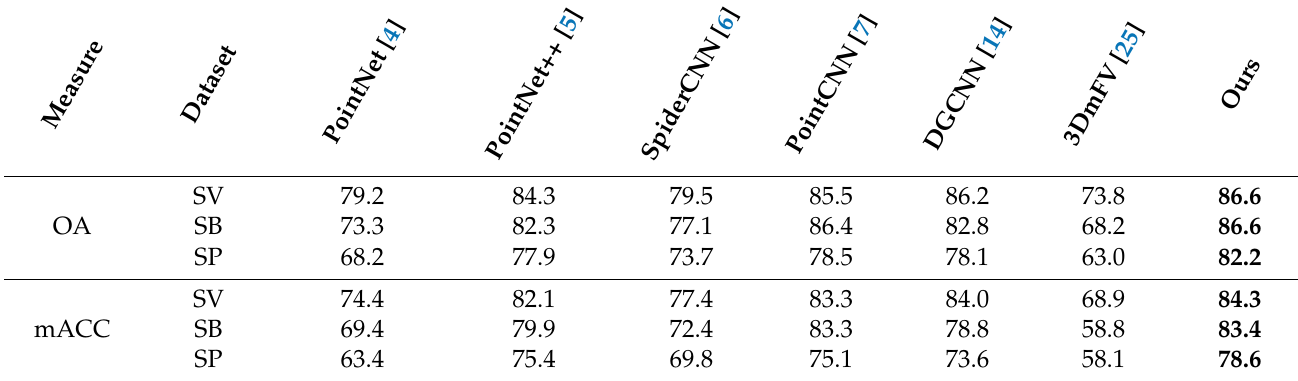
Table 2. Shape classification accuracy (OA and mACC in %) on ScanobjectNN-Vanilla (SV), ScanobjectNN-Background (SB), and ScanObjectNN-PB_T50_RS (SP). Our PSNet performs better than all of the compared methods for both OA and mACC measures on all the datasets.